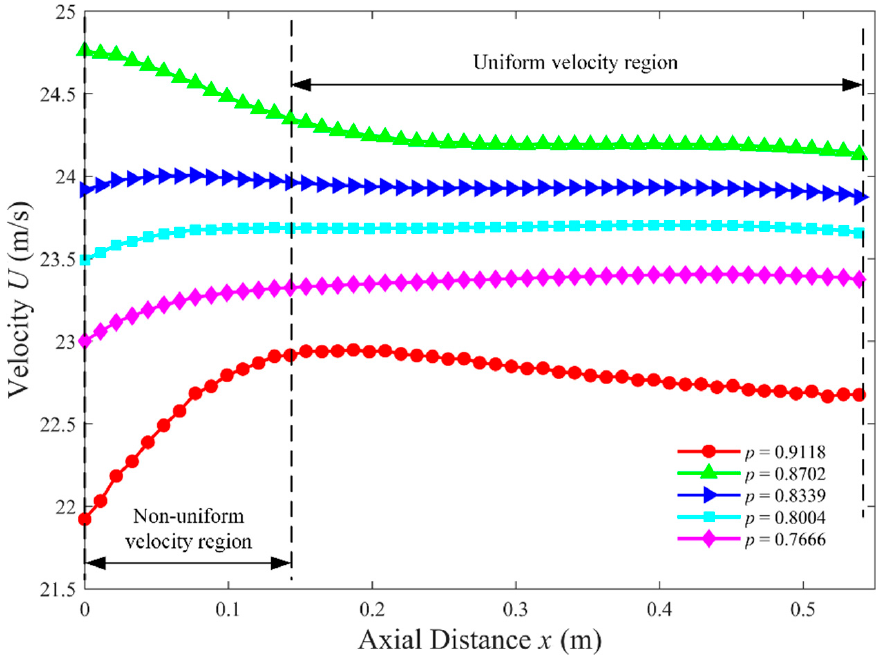
Figure 8. Variation of velocity distribution characteristics of the test section with axial distance under different honeycomb porosities.